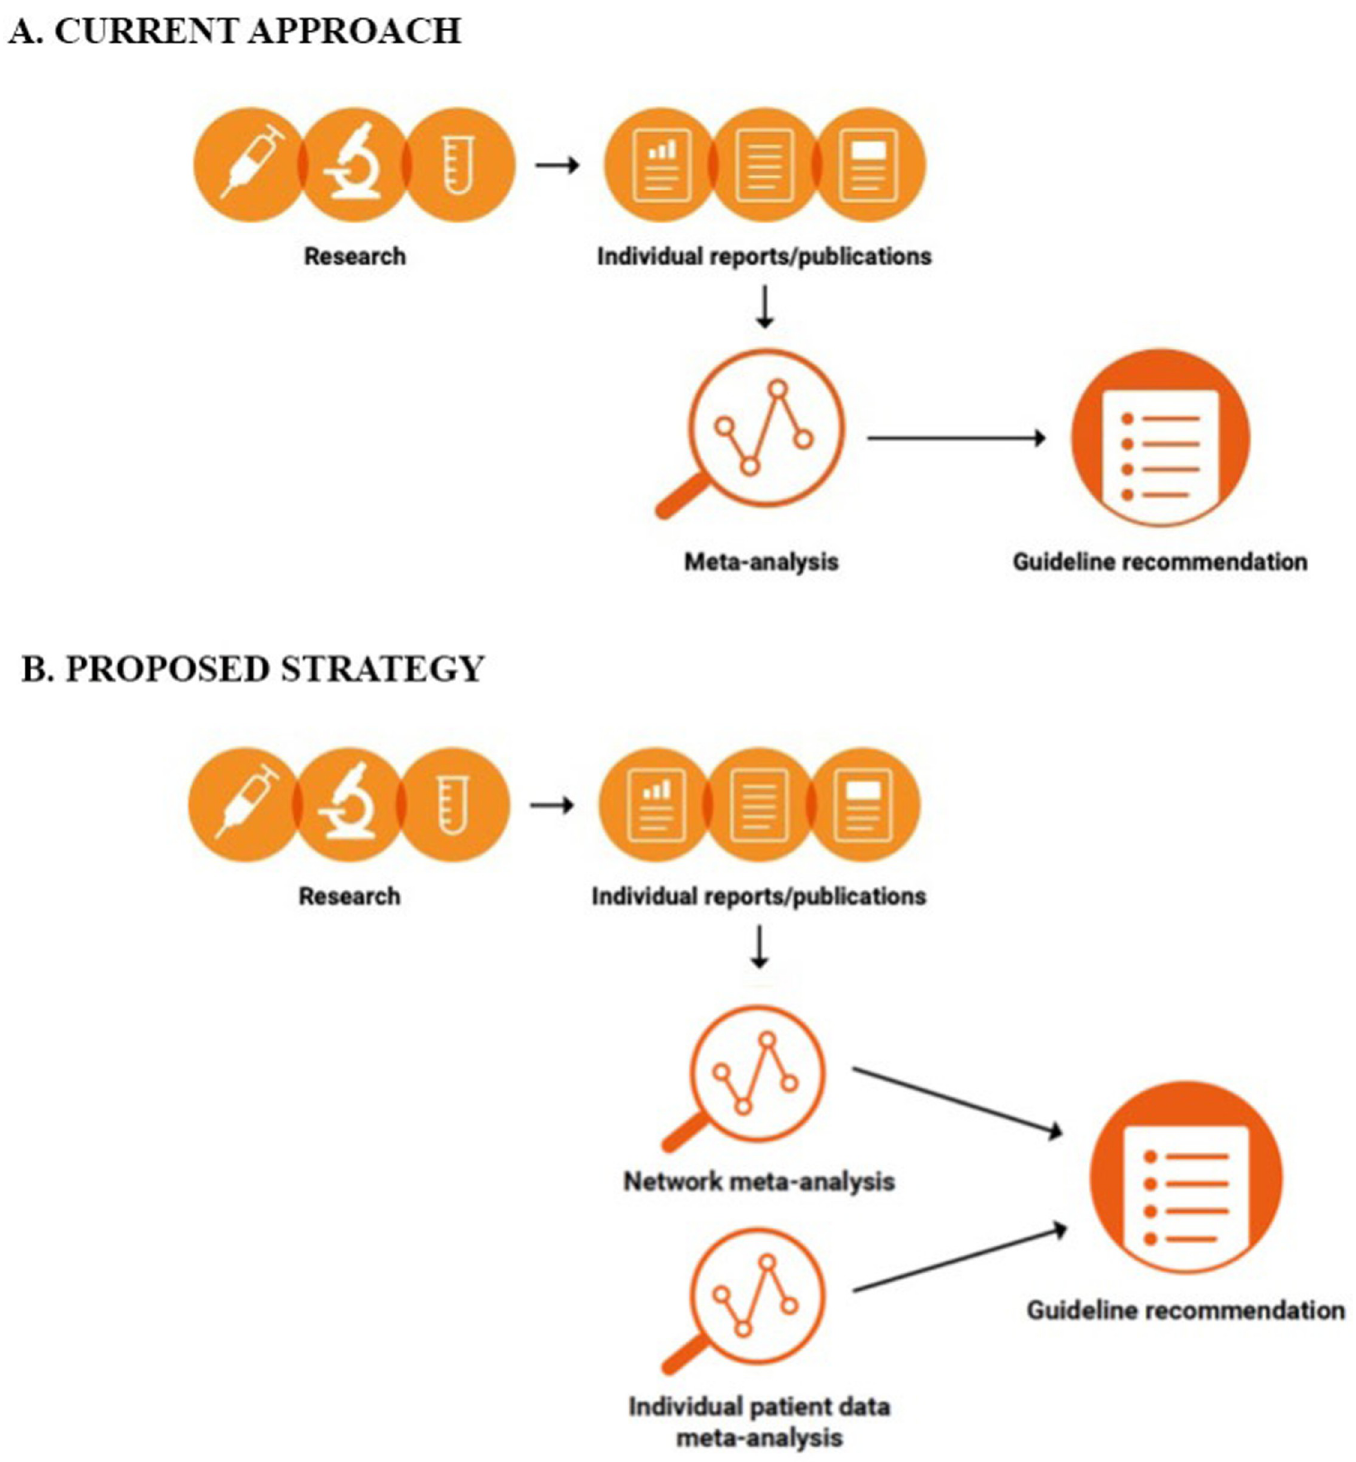
Fig 6. Proposed strategy to generate COVID-19 treatment guidelines.